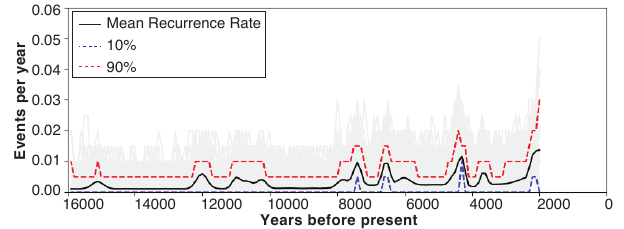
Figure 10: VEAM recurrence rate graph for Craters of the Moon. We use VEAM to help constrain the ages of undated vents and to guide in the selection of the Ma- halanobis distance cut-off value.